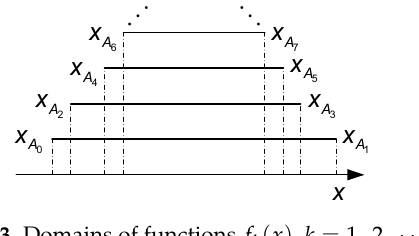
Figure 3. Domains of functions f k ( x ) , k = 1, 2, · · · m